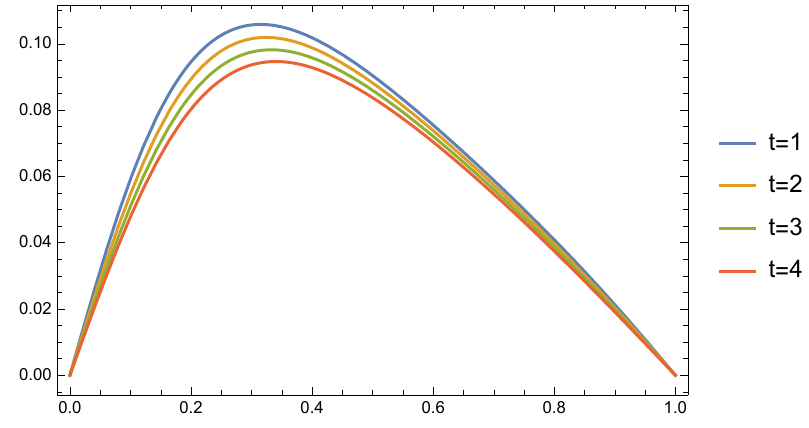
Figure 5. The approximate solutions of Example 3 at different times.